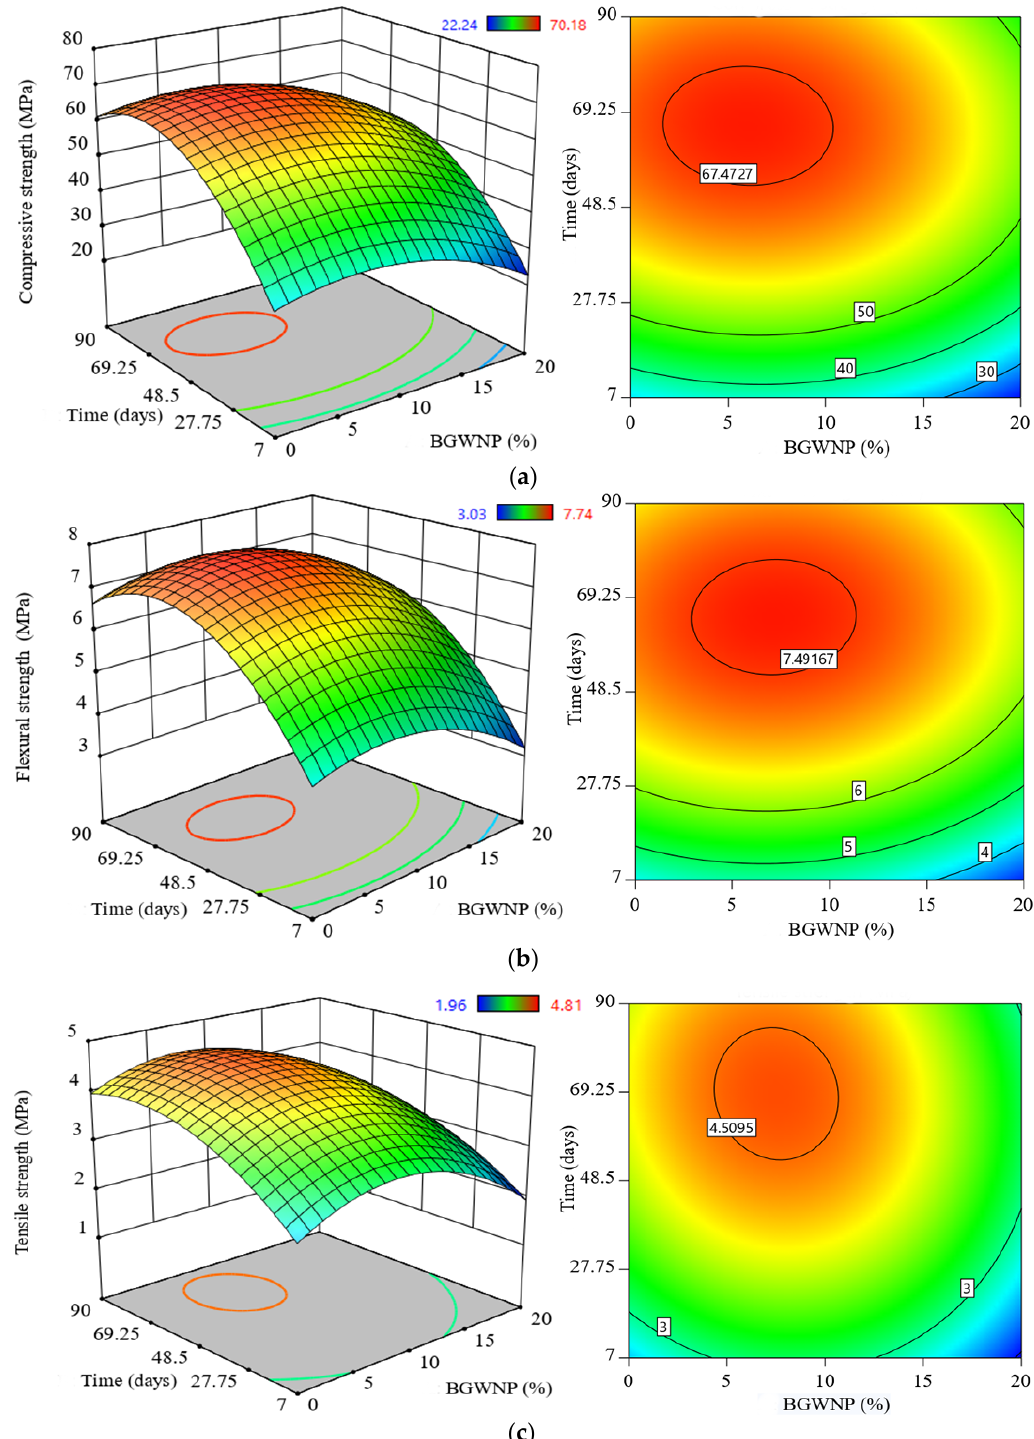
Figure 7. Evolution of ( a ) compressive strength, ( b ) flexural strength, and ( c ) tensile strength of FA-GBFS-based AAM with different amounts of BGWNP content.